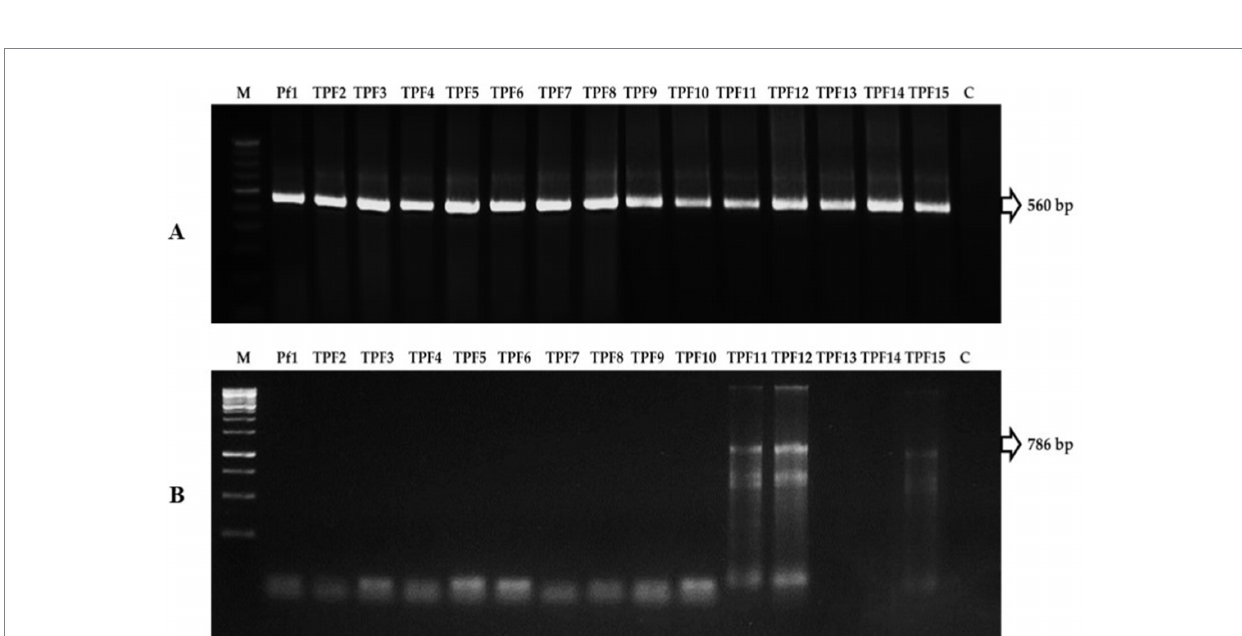
FIGURE 5 (A) PCR amplification of 16S-23S rRNA region in Pseudomonas fluorescens strains (M-Marker, Pf1-TPF15-strains, C-Control). (B) PCR amplification of pyrrolnitrin antibiotic gene region in P. fluorescens strains (M-Marker, Pf1-TPF15-strains, C-Control).